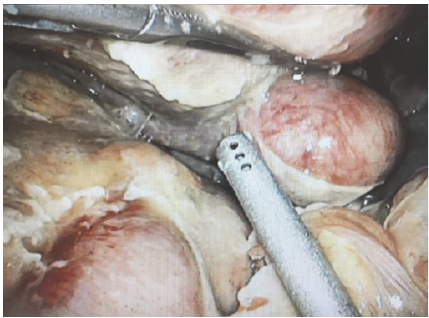
Figure 3: The uterine fundus is seen on the right hand side of the image. The pyomyoma is at the top of the